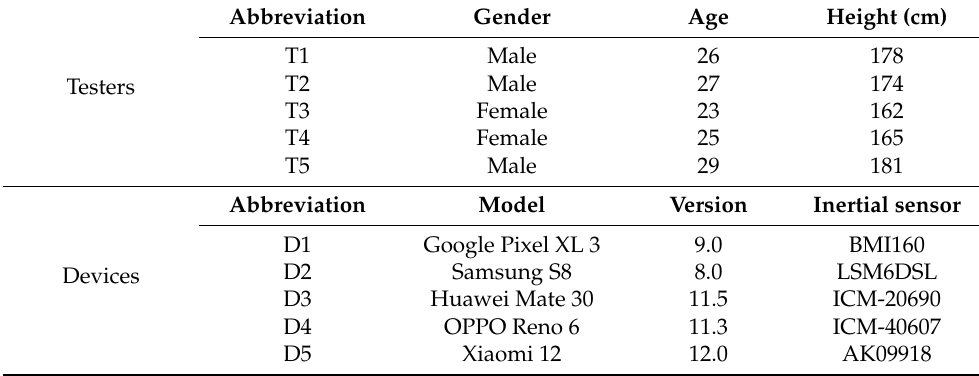
Table 1. Description of testers and devices.